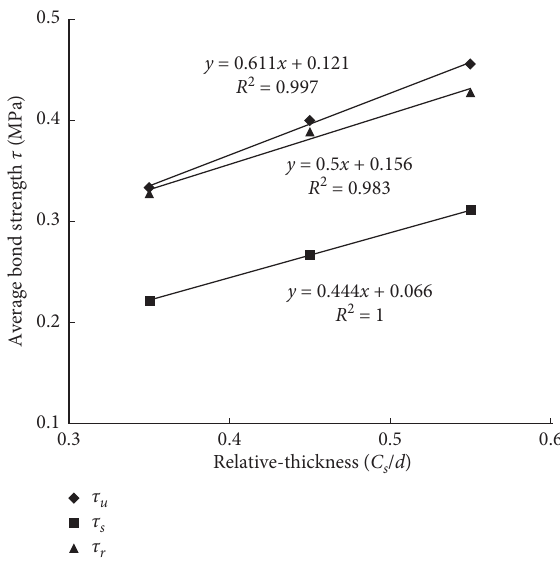
Figure 10: Relationship between τ and C